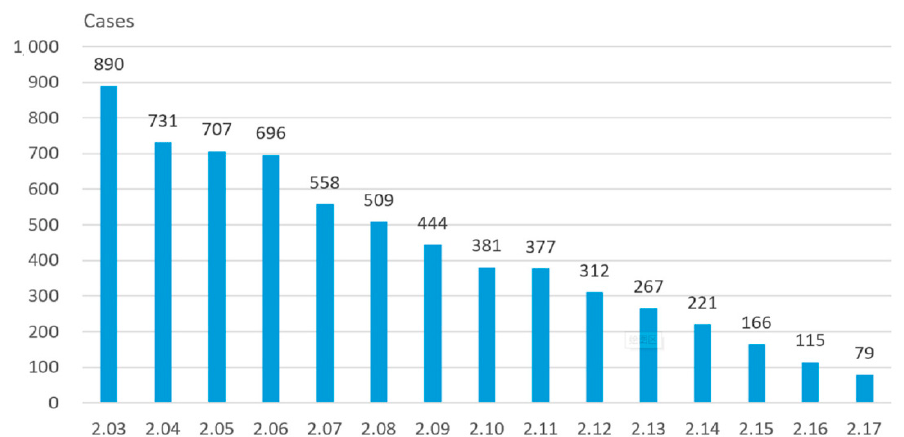
Figure 6. A diminishing trend of daily new cases in the non-Hubei area.